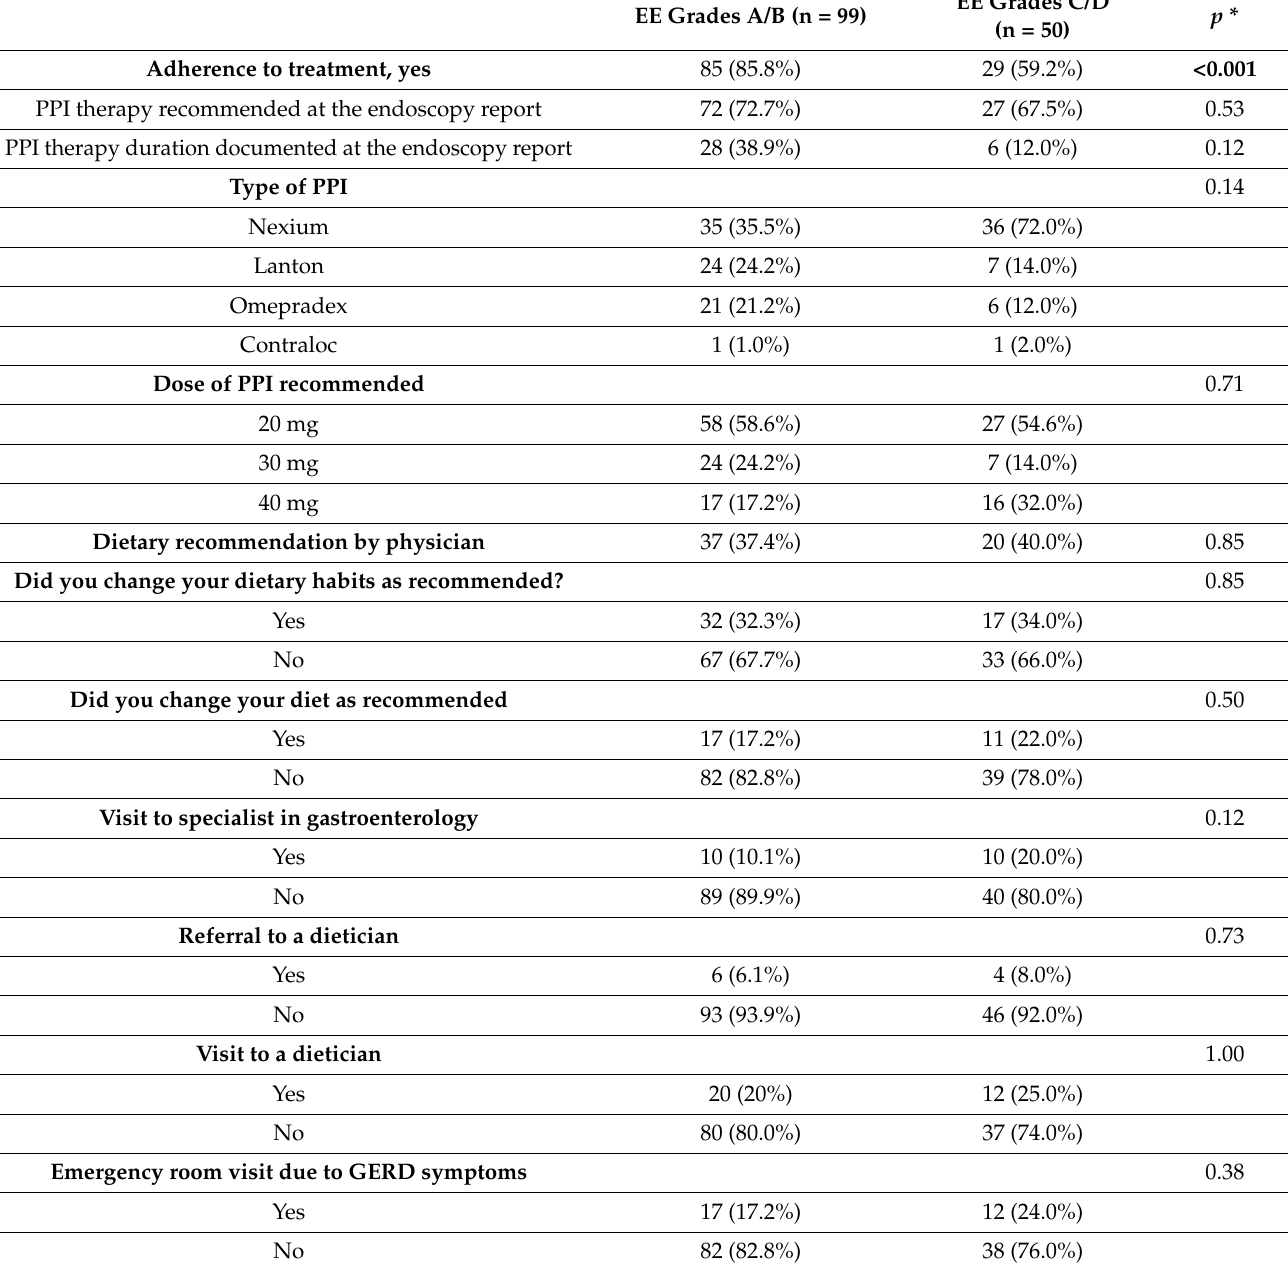
Table 2. Comparison between patients with mild-moderate EE grades A/B and those with severe EE grades C/D in adherence to treatment and health services